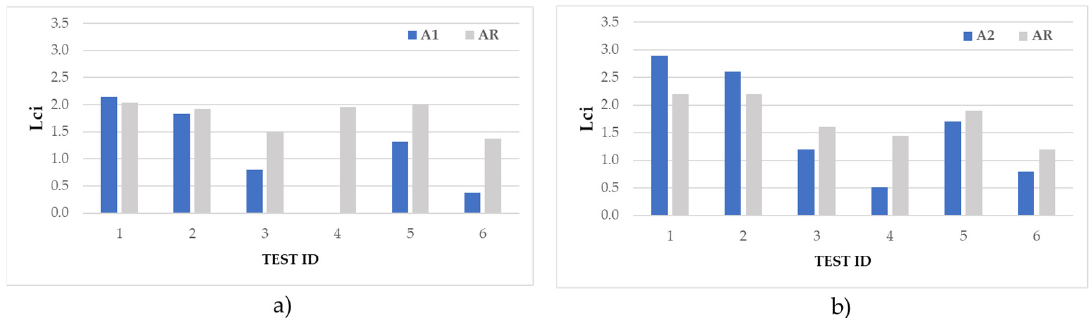
Figure 14. Accreted ice thickness t ice on A1 and AR ( a ), and on A2, and AR ( b ), during the IWT tests.